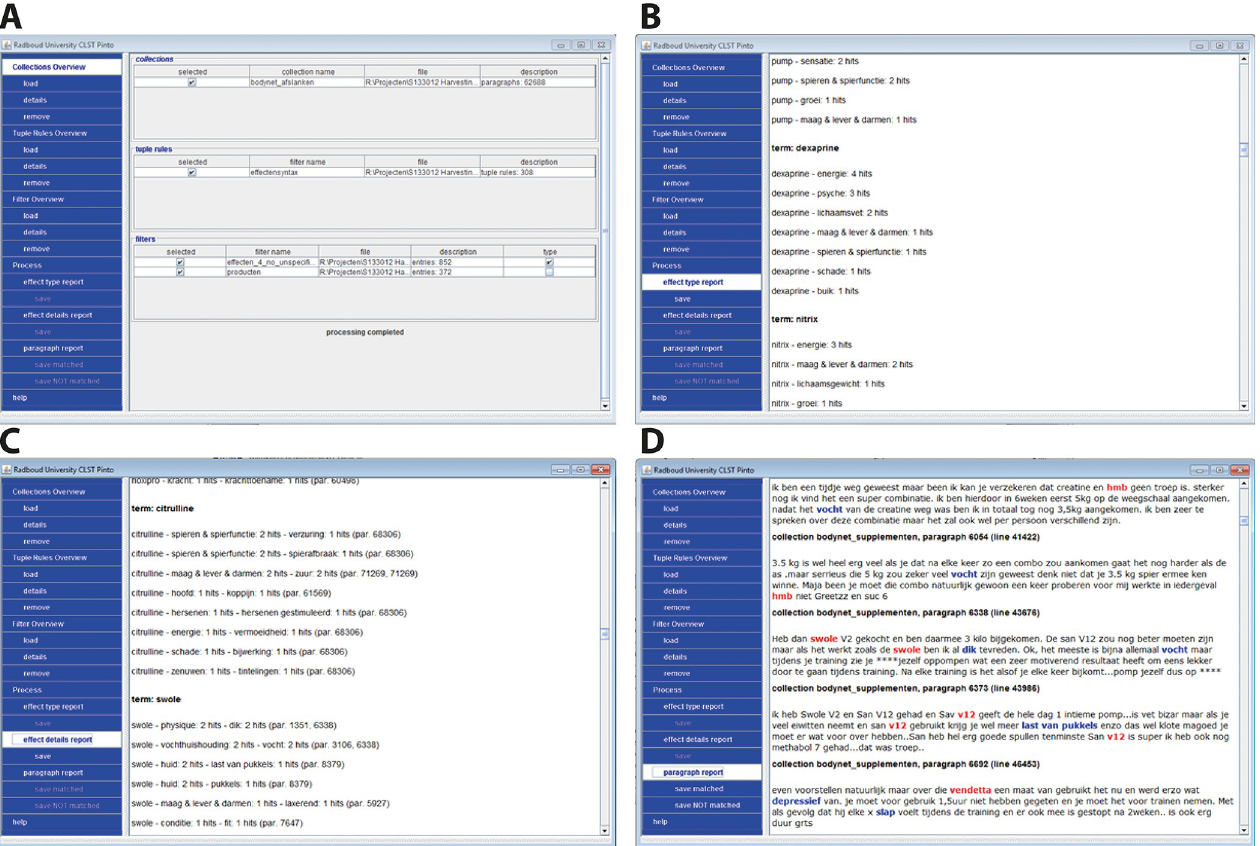
Fig 2. Interface of Pinto, displaying the overview of datasets, rules and filters (A), the results of a search in the effect type report (B), the effect details report (C), and the paragraph report (D).